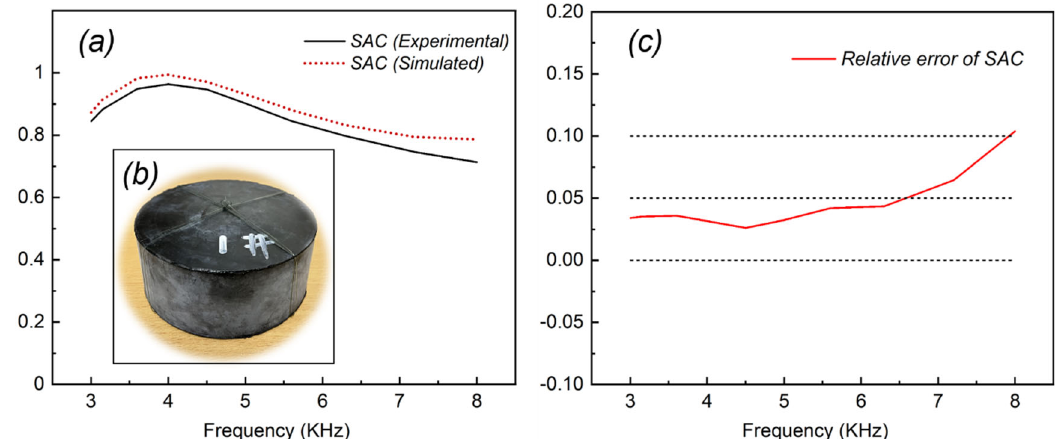
Figure 13. ( a ) Comparison of simulated and experimental sound absorption results; ( b ) the compression-molded PU-based composite; ( c ) the relative error curve of SAC results. Table 2. The relative error data of SAC results.